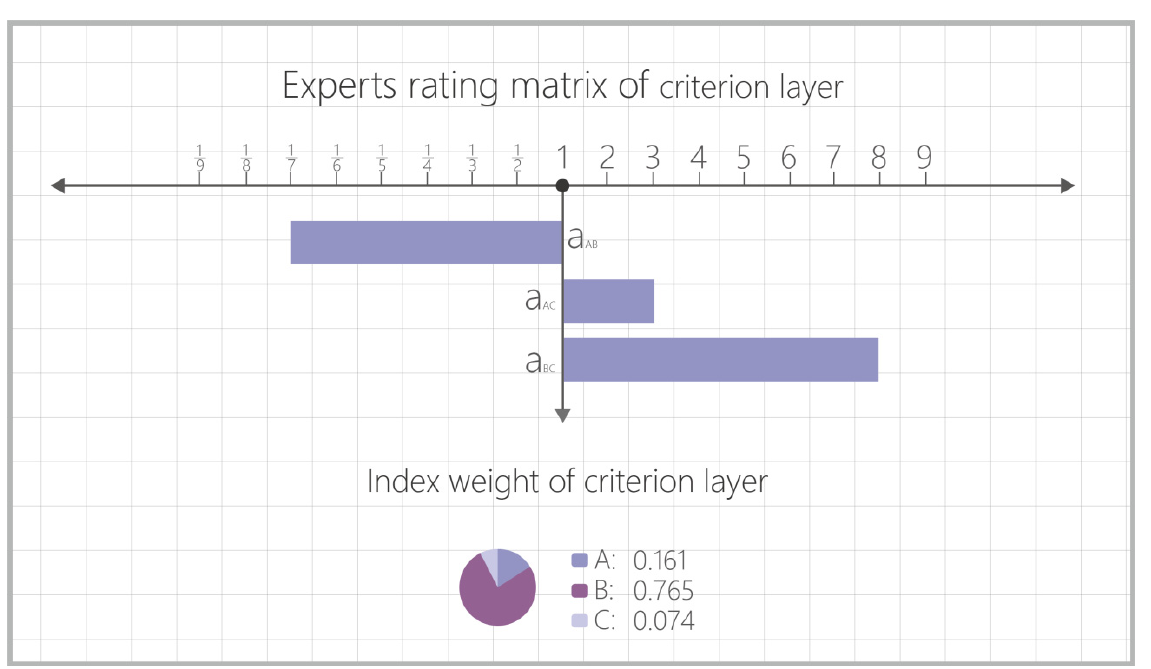
Figure 6. Experts’ rating judgment and index weight of criterion layer.